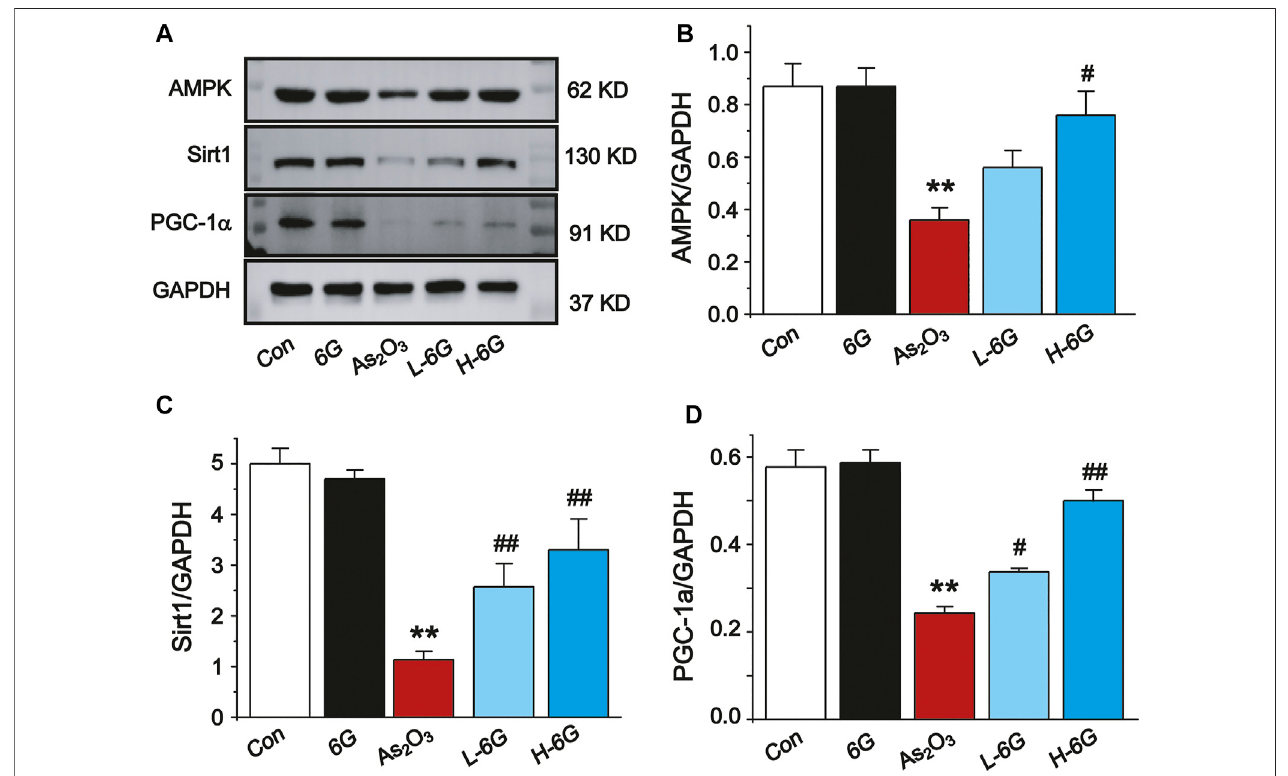
FIGURE 10 | Western blot analysis of AMPK, SIRT1, and PGC-1 α in cardiac homogenates prepared from mice, (A) The typical protein expression bands of each group.BargraphoftheexpressionsofAMPK (B) ,Sirt1 (C) andPGC-1 α (D) inmyocardialtissues.Dataareexpressedasmean±SEM, n =3.** p < 0.01asincomparison to the Con group and # p < 0.05, ## p < 0.05 as in comparison to the As 2 O 3